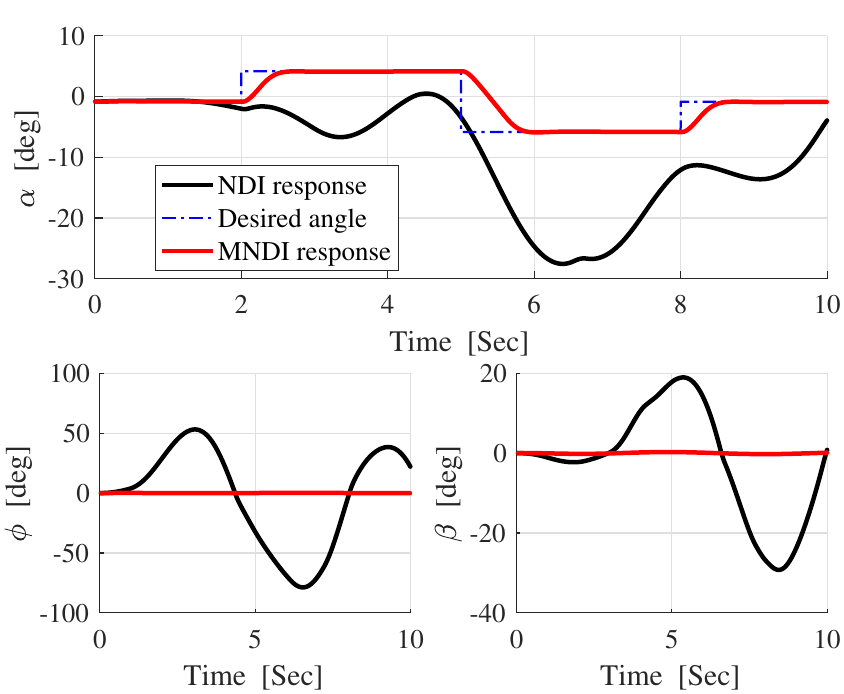
Figure 11. Attitudes response with NLDI and MNLDI with pitch angle excitation with wind disturbances and